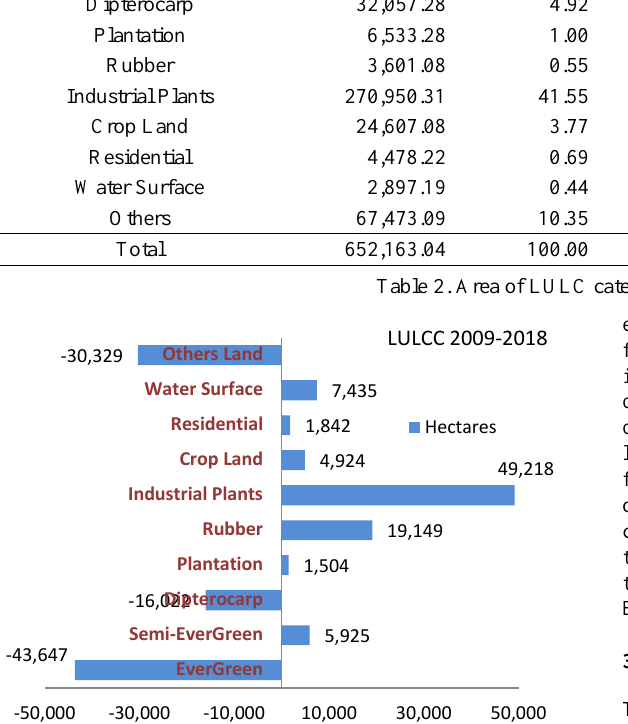
Figure 2. Land Use/Land Cover Net Changes in hectares from 2009 to 2018